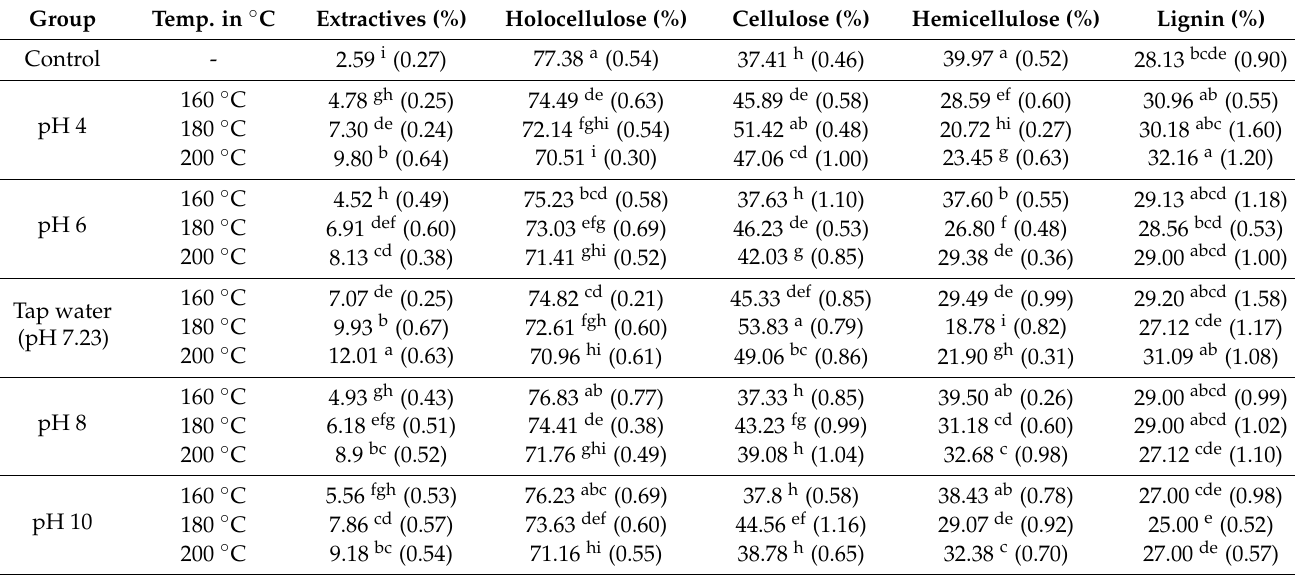
Table 1. Table of chemical analysis of